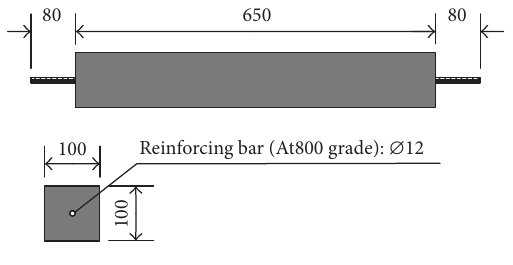
Figure 1: Details of the